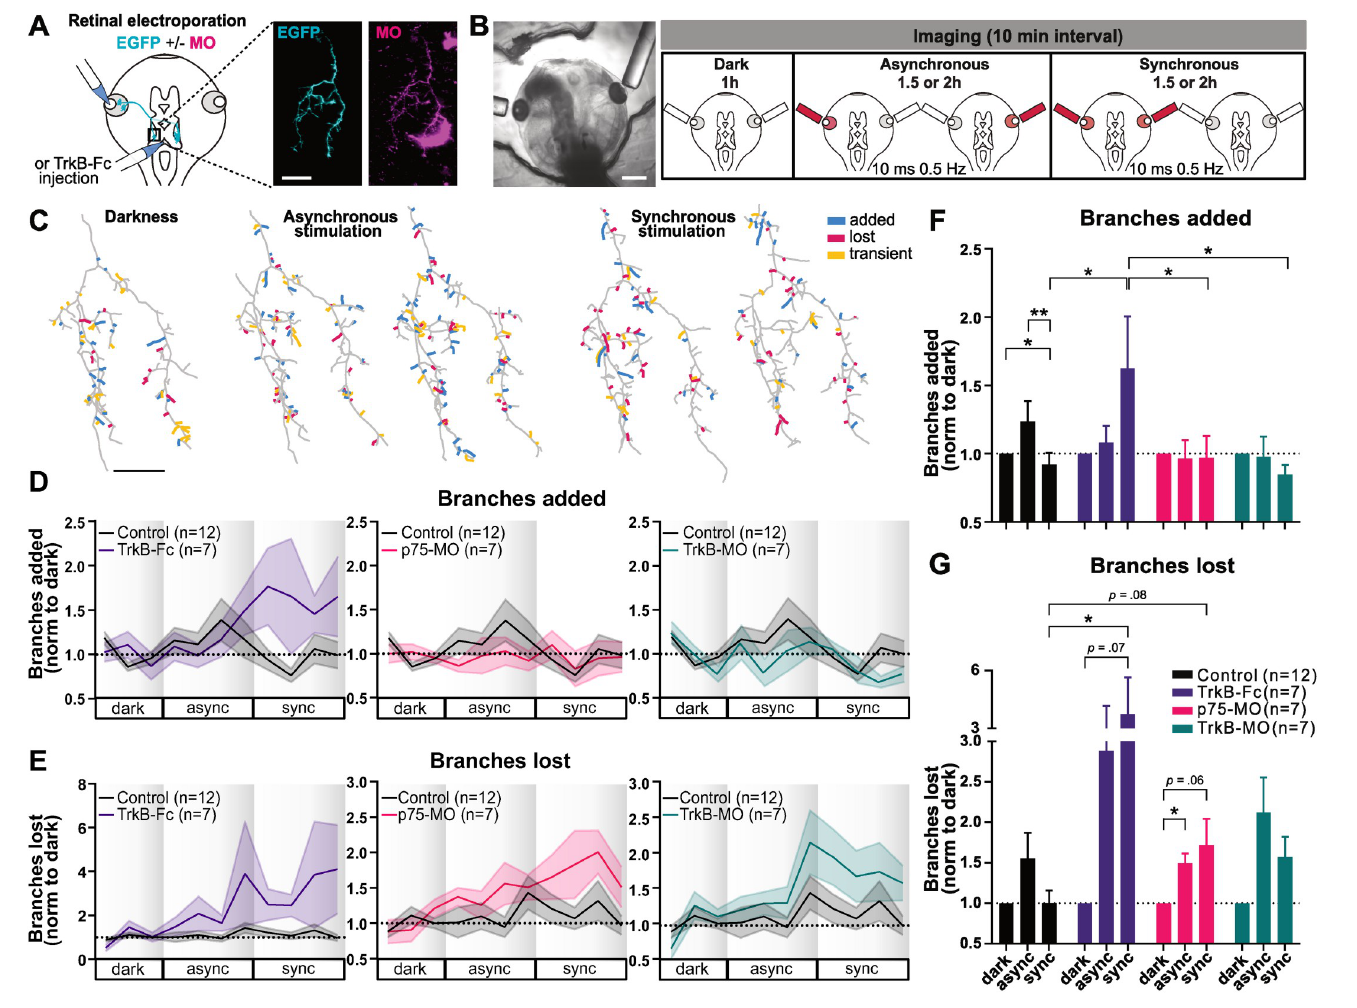
Fig 1. Blocking distinct components of BDNF signaling differentially affects correlation-dependent branch dynamics in ipsilaterally projecting RGC axons. (A) Retinal co-electroporation of EGFP and MO to visualize ipsi axons with receptor knockdown. Two-photon z-series projection of ipsi axon with EGFP (cyan) and lissamine-tagged Ctrl-MO (magenta). In magenta, 2 microglia are also visible. For TrkB-Fc experiments, intraventricular injection was performed > 1 h prior to imaging. (B) Visual stimulation (10 ms light flash; 0.5 Hz) delivered via optic fibers positioned by the tadpoles’ eyes. Ipsi axons were imaged every 10 min: 1 h Darkness, 1.5 h or 2 h Asynchronous, 1.5 h or 2 h Synchronous stimulation (DAS: shorter protocol used for intraventricular TrkB-Fc). (C) Reconstructed arbors showing added, lost, and transient branches (added and lost within the summarized period). Drawings summarize branch dynamics over 1 h. Time course (20 min average) of branch (D) additions and (E) losses normalized to the average in darkness, DAS (1 h, 1.5 h, 1.5 h). Average branch (F) addition in the first and (G) loss rates in the second half of stimulation. Significant interactions in the two-way mixed design model: (F) p = 0.0189; (G) p < 0.001. (Within-subject factor: stimulation; between-subject factor: BDNF manipulation); post hoc tests corrected for multiple comparisons (BKY two-stage linear step-up procedure): * p � 0.05, ** p � 0.01. Graphs show mean ± SEM. (D–G) Control ( n = 12), TrkB-Fc ( n = 7), p75-MO ( n = 7), TrkB-MO ( n = 7). Scale bars: (A, C) 20 μ m; (B) 500 μ m. The data used to generate Fig 1D and 1E can be found in S1 Data and Fig 1F and 1G in S2 Data. BDNF, brain-derived neurotrophic factor; DAS, Darkness-Asynchronous-Synchronous; EGFP, enhanced green fluorescent protein; MO, morpholino oligonucleotide; RGC, retinal ganglion cell.